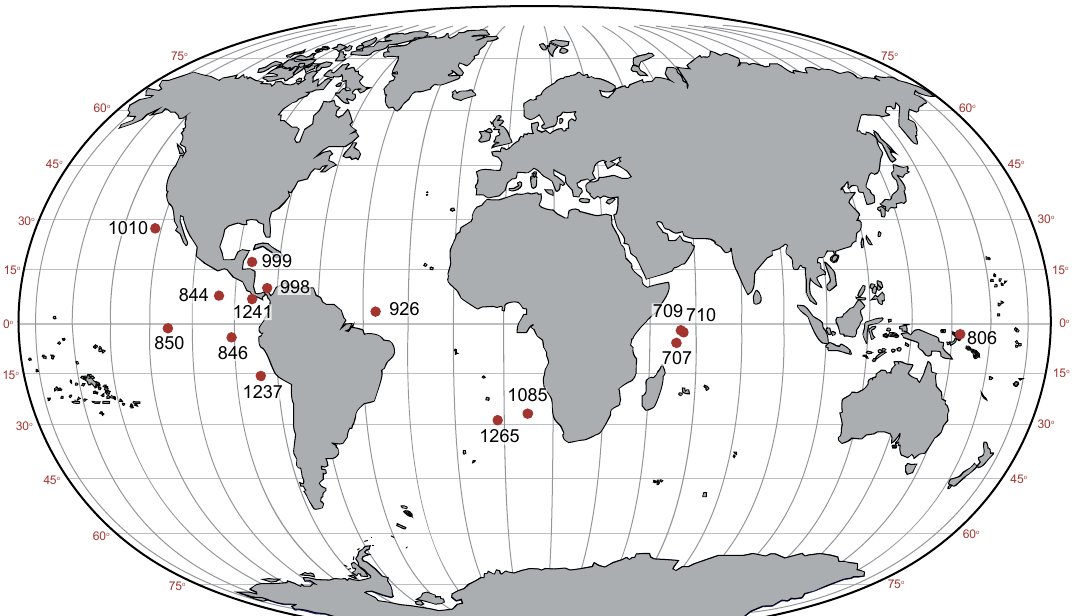
Figure 2. Locations of Ocean drilling program (ODP) sites reviewed in the present study for exhibiting Carbonate Crash events. New data from Site 1237 in the SE-Pacific.